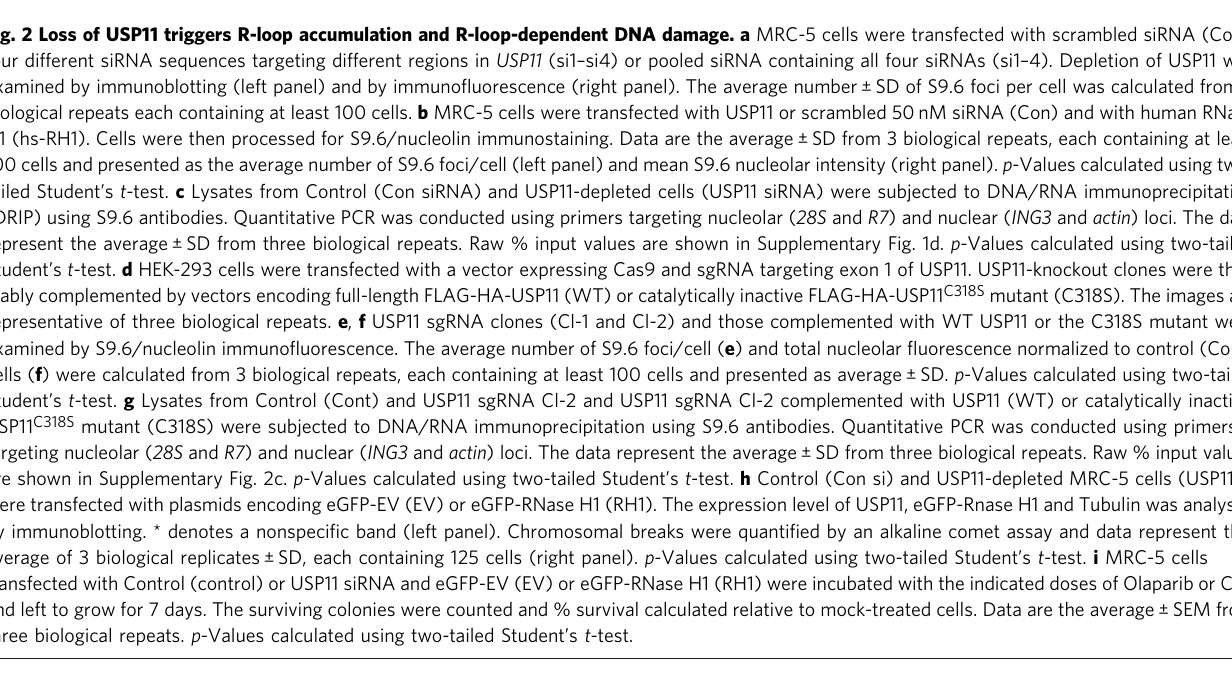
Fig. 2 Loss of USP11 triggers R-loop accumulation and R-loop-dependent DNA damage. a MRC-5 cells were transfected with scrambled siRNA (Con), four different siRNA sequences targeting different regions in USP11 (si1 – si4) or pooled siRNA containing all four siRNAs (si1 – 4). Depletion of USP11 was examined by immunoblotting (left panel) and by immuno fl uorescence (right panel). The average number ± SD of S9.6 foci per cell was calculated from 3 biological repeats each containing at least 100 cells. b MRC-5 cells were transfected with USP11 or scrambled 50 nM siRNA (Con) and with human RNase H1 (hs-RH1). Cells were then processed for S9.6/nucleolin immunostaining. Data are the average ± SD from 3 biological repeats, each containing at least 100 cells and presented as the average number of S9.6 foci/cell (left panel) and mean S9.6 nucleolar intensity (right panel). p -Values calculated using two- tailed Student ’ s t -test. c Lysates from Control (Con siRNA) and USP11-depleted cells (USP11 siRNA) were subjected to DNA/RNA immunoprecipitation (DRIP) using S9.6 antibodies. Quantitative PCR was conducted using primers targeting nucleolar ( 28S and R7 ) and nuclear ( ING3 and actin ) loci. The data represent the average ± SD from three biological repeats. Raw % input values are shown in Supplementary Fig. 1d. p -Values calculated using two-tailed Student ’ s t -test. d HEK-293 cells were transfected with a vector expressing Cas9 and sgRNA targeting exon 1 of USP11. USP11-knockout clones were then stably complemented by vectors encoding full-length FLAG-HA-USP11 (WT) or catalytically inactive FLAG-HA-USP11 C318S mutant (C318S). The images are representative of three biological repeats. e , f USP11 sgRNA clones (Cl-1 and Cl-2) and those complemented with WT USP11 or the C318S mutant were examined by S9.6/nucleolin immuno fl uorescence. The average number of S9.6 foci/cell ( e ) and total nucleolar fl uorescence normalized to control (Cont) cells ( f ) were calculated from 3 biological repeats, each containing at least 100 cells and presented as average ± SD. p -Values calculated using two-tailed Student ’ s t -test. g Lysates from Control (Cont) and USP11 sgRNA Cl-2 and USP11 sgRNA Cl-2 complemented with USP11 (WT) or catalytically inactive USP11 C318S mutant (C318S) were subjected to DNA/RNA immunoprecipitation using S9.6 antibodies. Quantitative PCR was conducted using primers targeting nucleolar ( 28S and R7 ) and nuclear ( ING3 and actin ) loci. The data represent the average ± SD from three biological repeats. Raw % input values are shown in Supplementary Fig. 2c. p -Values calculated using two-tailed Student ’ s t -test. h Control (Con si) and USP11-depleted MRC-5 cells (USP11si) were transfected with plasmids encoding eGFP-EV (EV) or eGFP-RNase H1 (RH1). The expression level of USP11, eGFP-Rnase H1 and Tubulin was analysed by immunoblotting. * denotes a nonspeci fi c band (left panel). Chromosomal breaks were quanti fi ed by an alkaline comet assay and data represent the average of 3 biological replicates± SD, each containing 125 cells (right panel). p -Values calculated using two-tailed Student ’ s t -test. i MRC-5 cells transfected with Control (control) or USP11 siRNA and eGFP-EV (EV) or eGFP-RNase H1 (RH1) were incubated with the indicated doses of Olaparib or CPT and left to grow for 7 days. The surviving colonies were counted and % survival calculated relative to mock-treated cells. Data are the average ± SEM from three biological repeats. p -Values calculated using two-tailed Student ’ s t